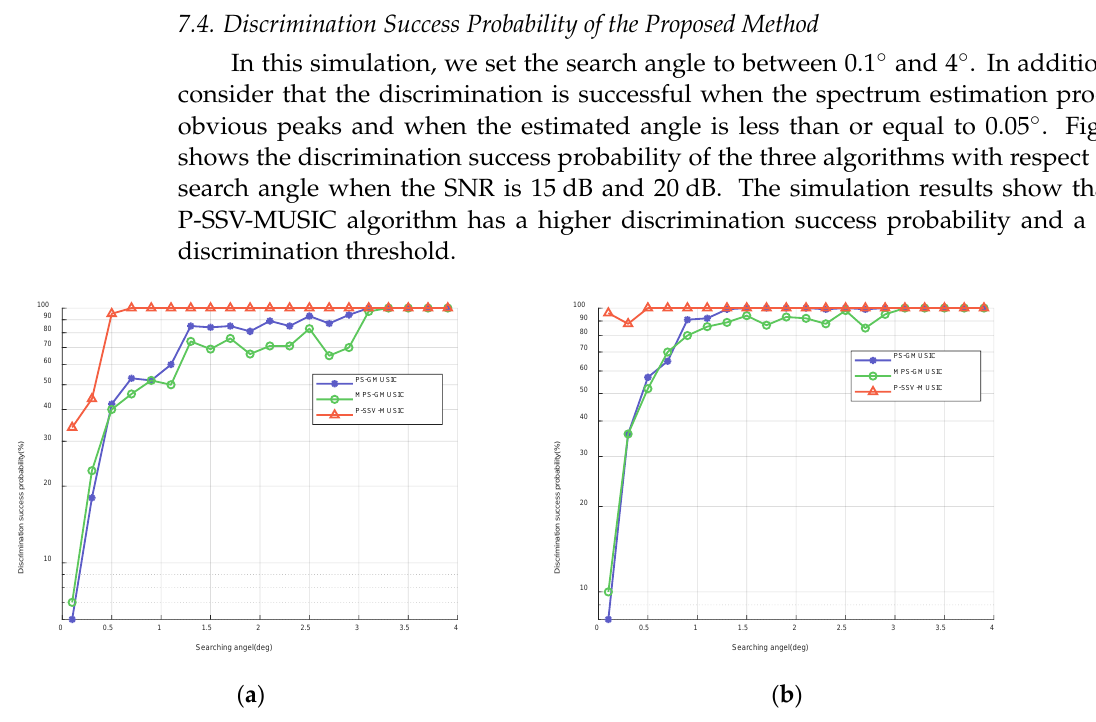
( a ) θ d = 1 ◦ ; ( b ) θ d = 2 ◦ .